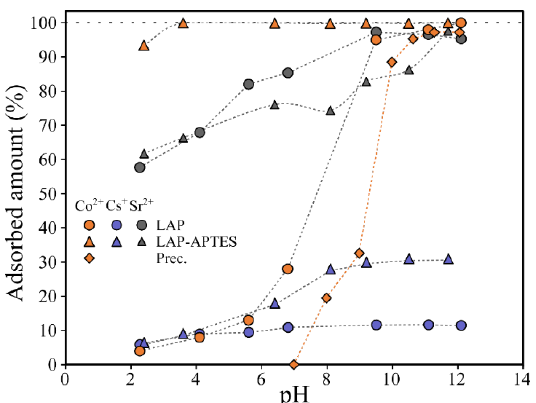
Figure 5. Impact of pH on the competitive adsorption of Cs + (blue), Co 2+ (orange) and Sr 2+ (grey) onto LAP (squares) and LAP-APTES-4CEC (triangles). Diamonds represent the precipitated amount of Co 2+ .